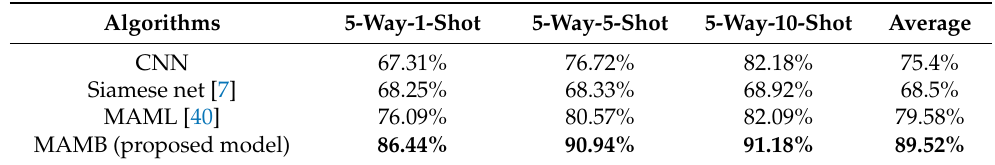
Table 6. Comparison of MAMB with different algorithms in the few-shot diagnosis of the gearboxes for wind turbines.